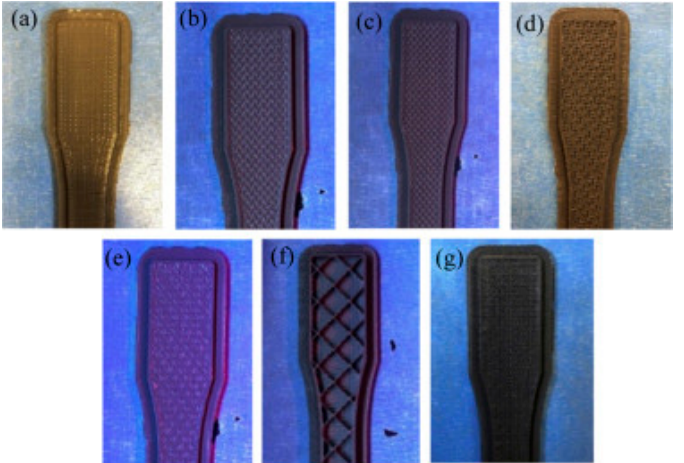
Figure 8. 3D-printed samples with different infill patterns: ( a ) Linear; ( b ) hexagonal; ( c ) moroccan- star; ( d ) catfill; ( e ) sharkfill; ( f ) diamond; ( g ) Hilbert (adapted with permission from reference [29]).